Question: Identify the chart type used in this figure.
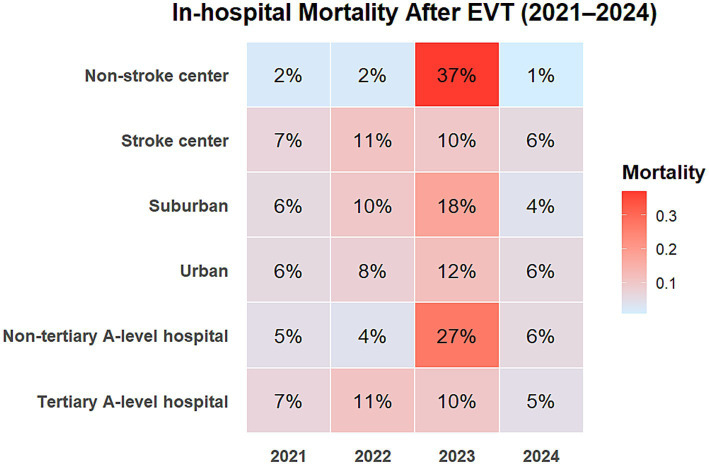
Answer: heatmap